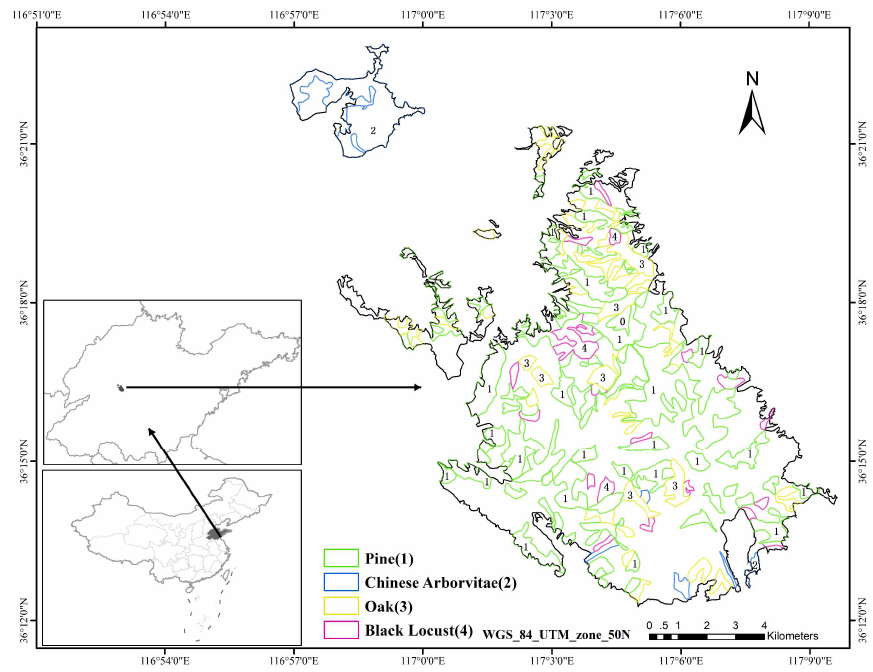
Figure 1. Location map of the study area and tree species distribution of pure forest area (produced from subcompartment